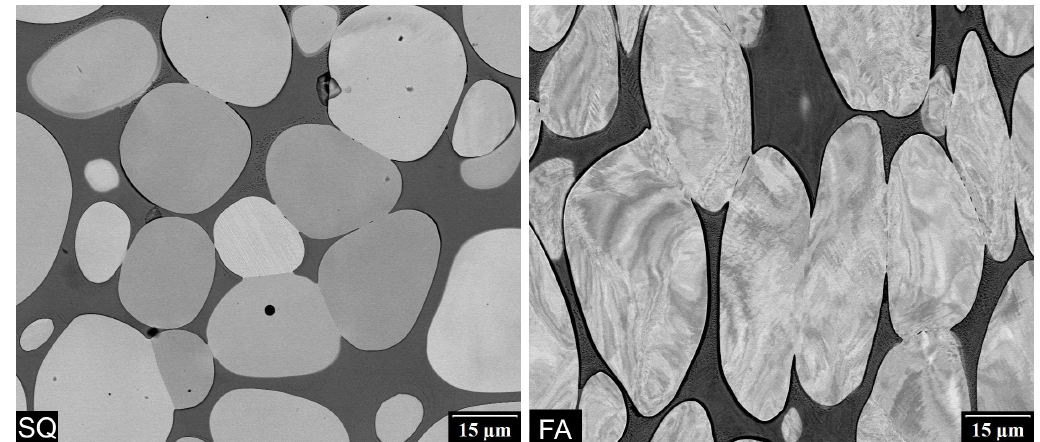
Figure 7. The influence of rotary forging on microstructure of W particles and Ni matrix observed using SEM in backscattered electron channeling contrast